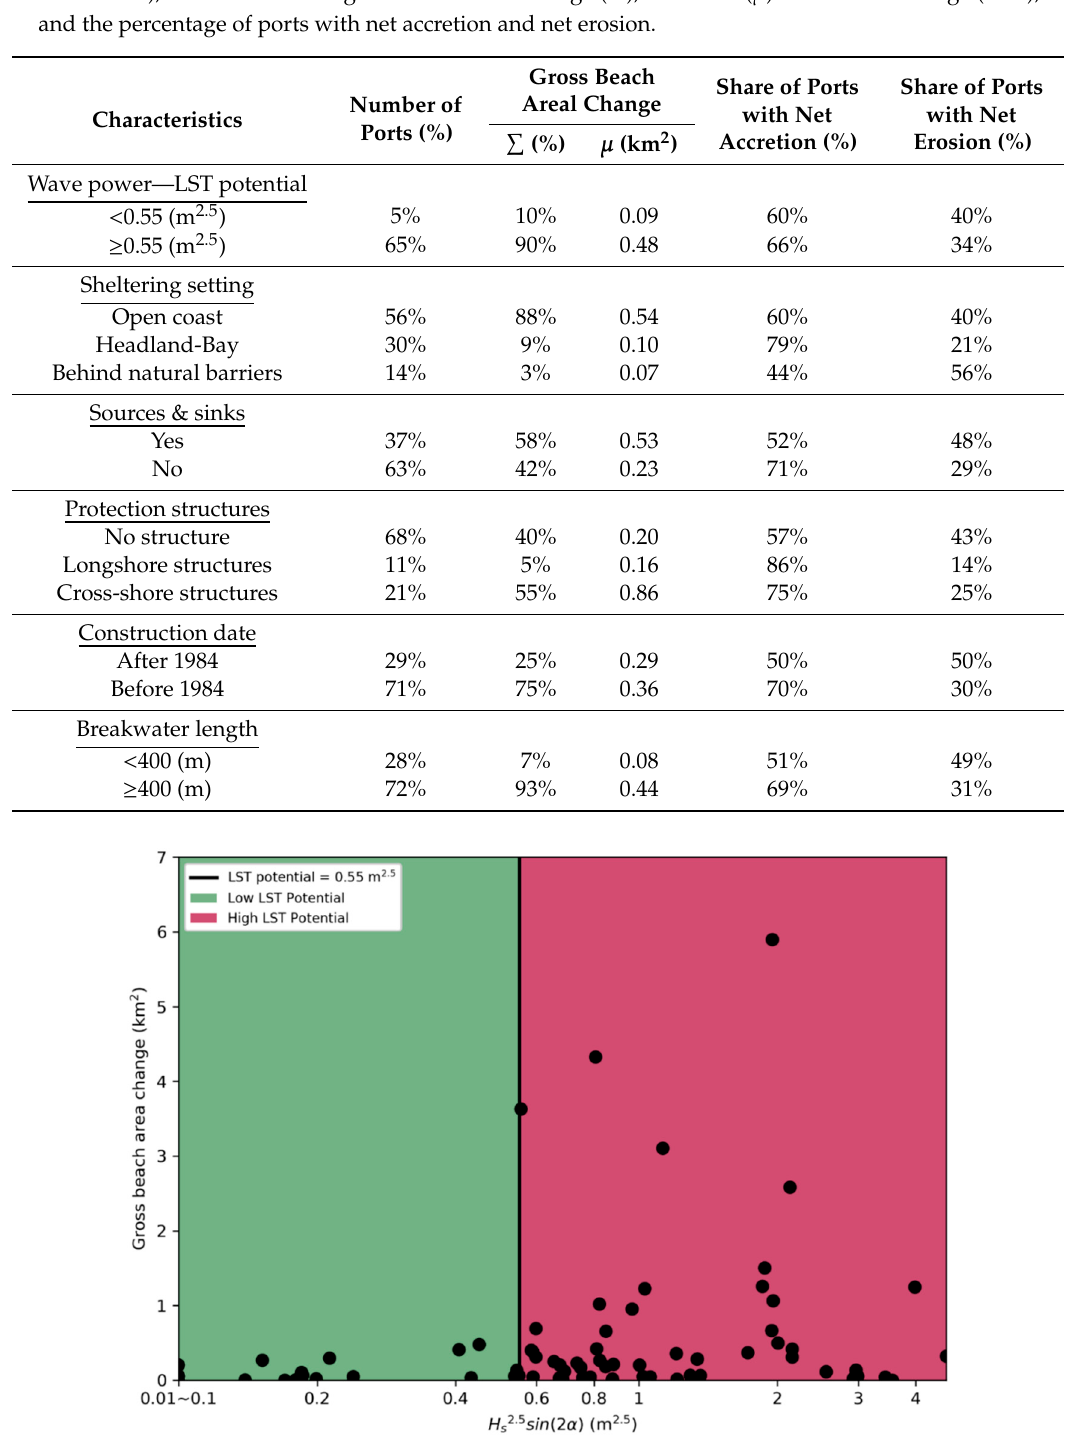
Figure 12. The LST potential (i.e., H 2.5 s sin ( 2 α ) ) plotted against the present beach accretion rates (km 2 / year) for all ports located at open coasts.